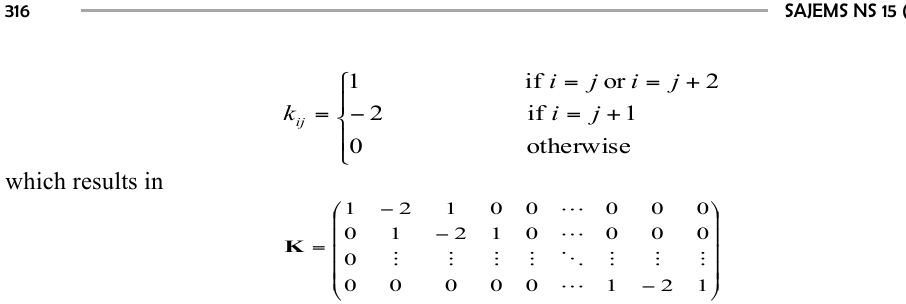
One-­‐sided HP filtered series as at 09/10 Two-­‐sided HP filtered series as at